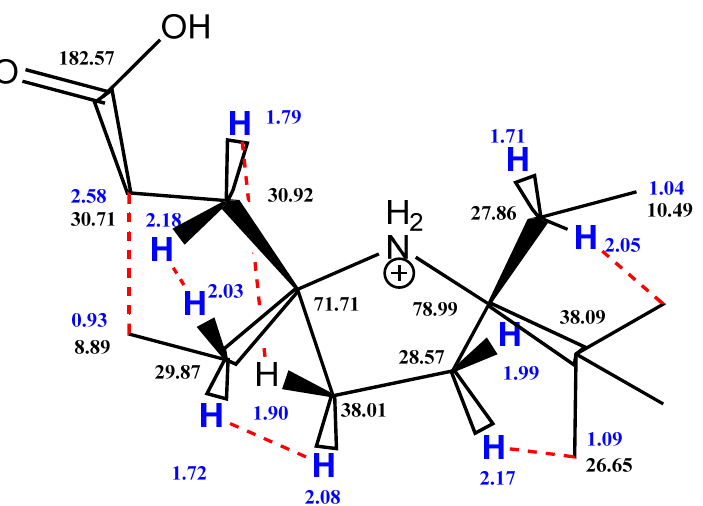
12 of 13 Figure A1. (top) Real and (bottom) simulated (fragment of pyrrolidine ring) 1 H-NMR spectra. Weak cross-peaks in the 1 H, 1 H–NOESY spectrum showed interaction of the methyl group at 1.09 ppm with protons at 2.17 ppm (methylene group of pyrrolidine ring) and at